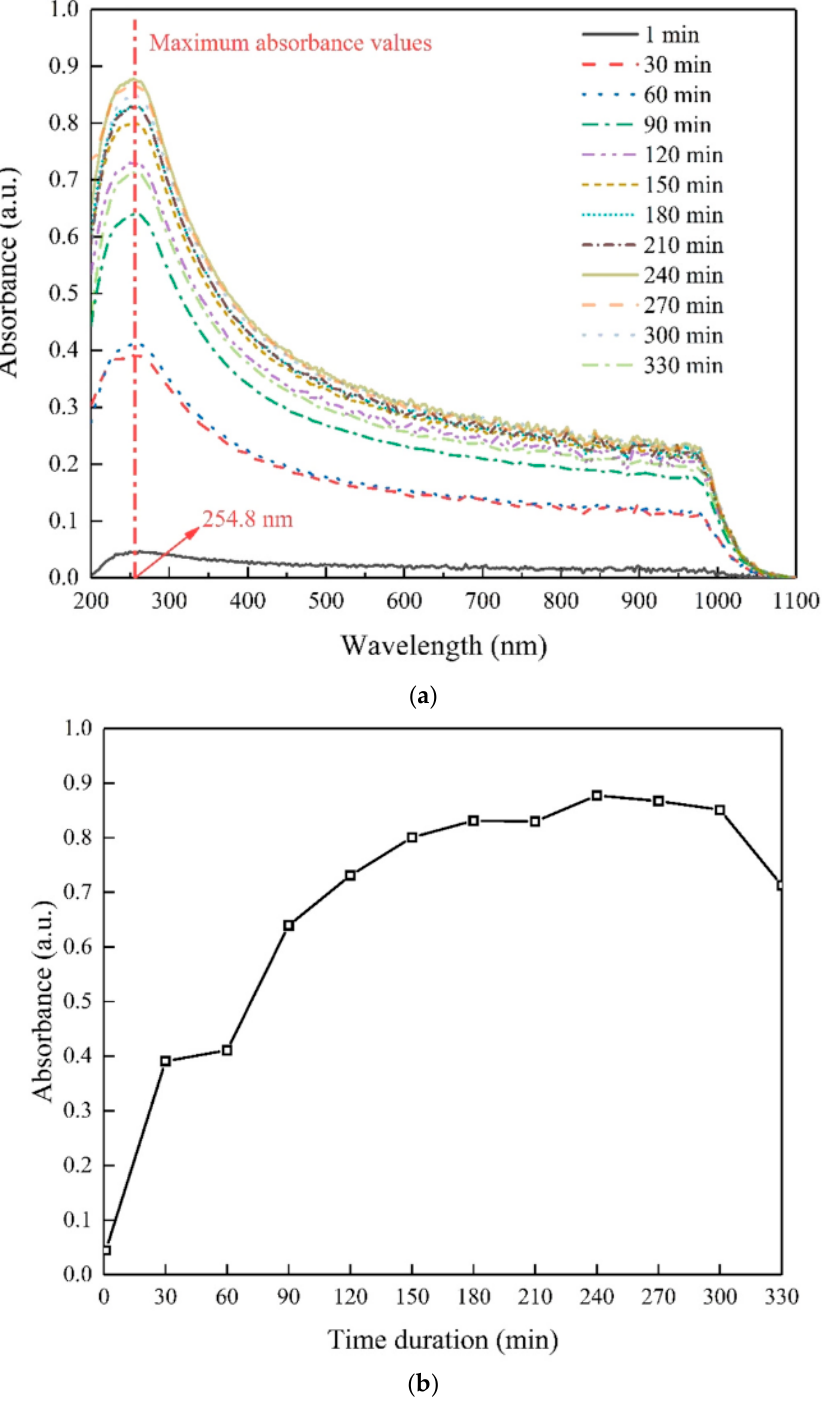
Figure 4. Ultraviolet-visible absorbance of MWCNT dispersed in SDBS solution under ultrasound at 25 kHz, ( a ) effect of different treatment and wavelengths, ( b ) effect of wavelength at 254.8 nm (reprinted from Li et al. [12] Copyright 2022, LN 5324970158358, with permission from